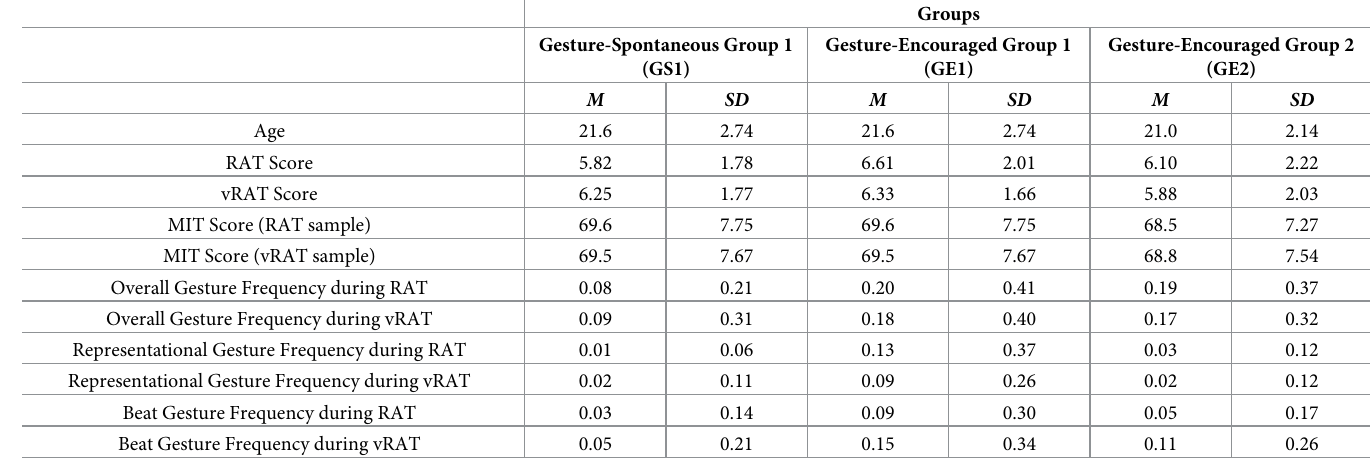
Table 1. Mean ( M ) and standard deviation ( SD ) values of age, RAT, vRAT, and MIT scores and gesture frequency across groups.